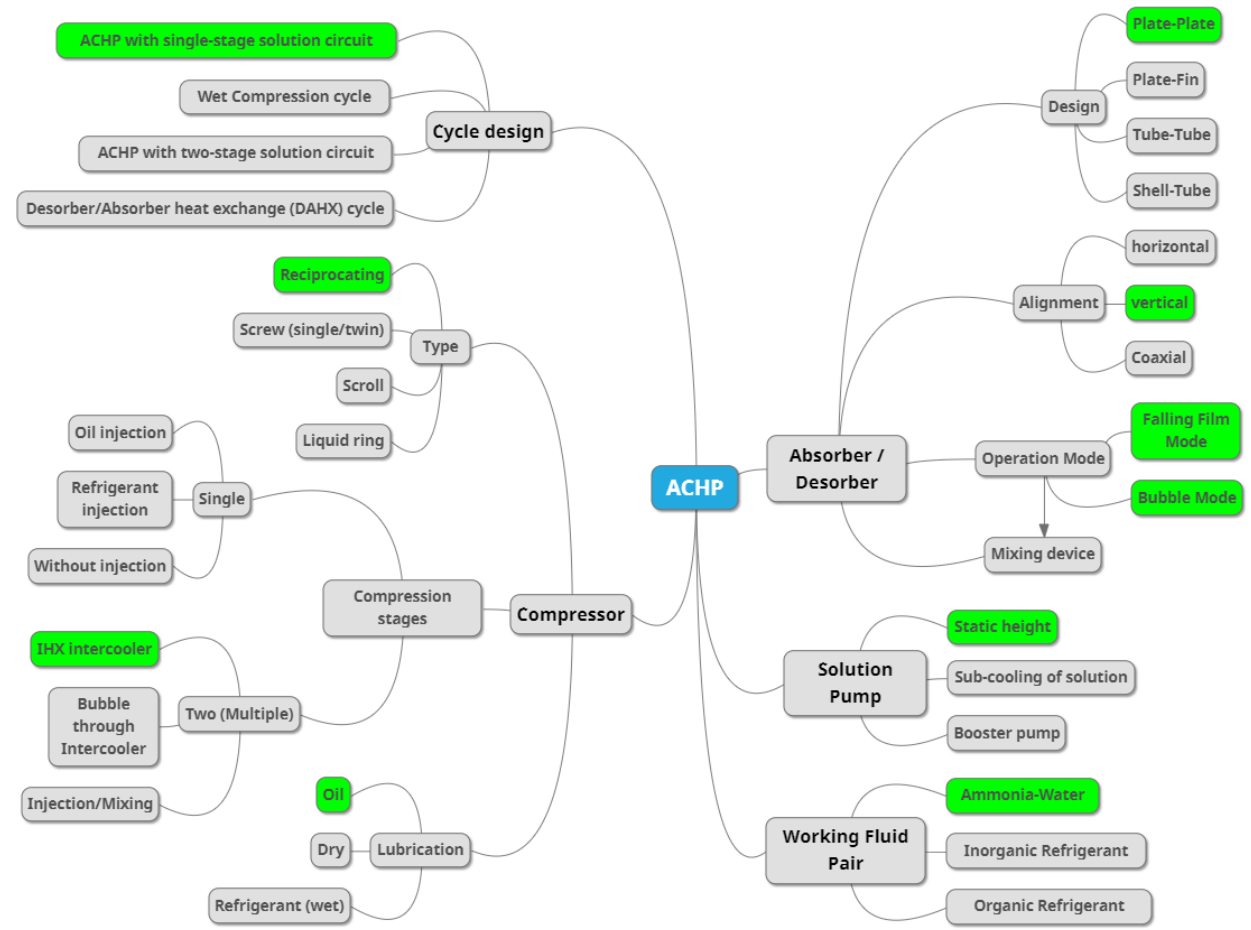
Figure 6. Overview of recent developments and existing solutions for the realization of ACHP systems (fields highlighted in green indicate the currently most frequently used solutions for commercial applications of each system part).